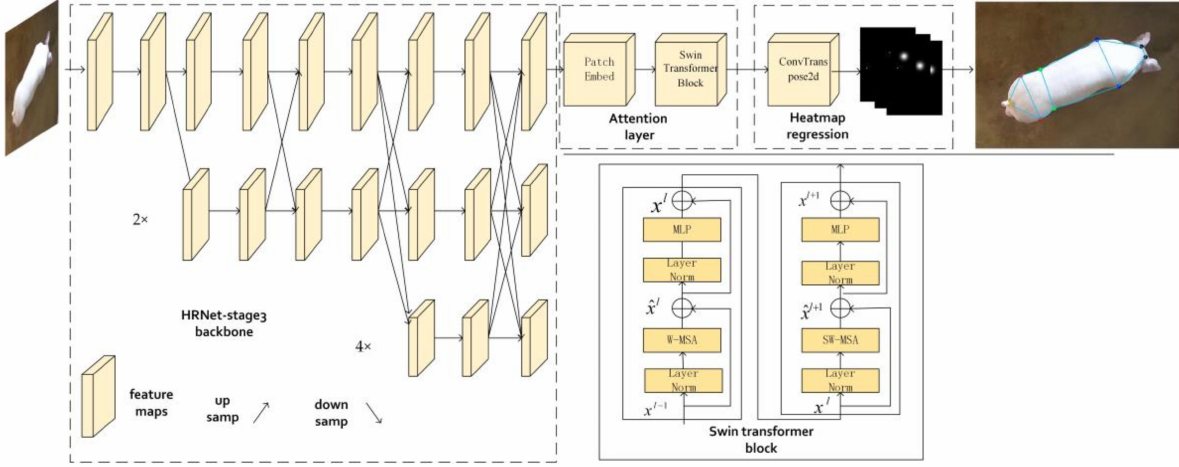
Figure 3. HRST model